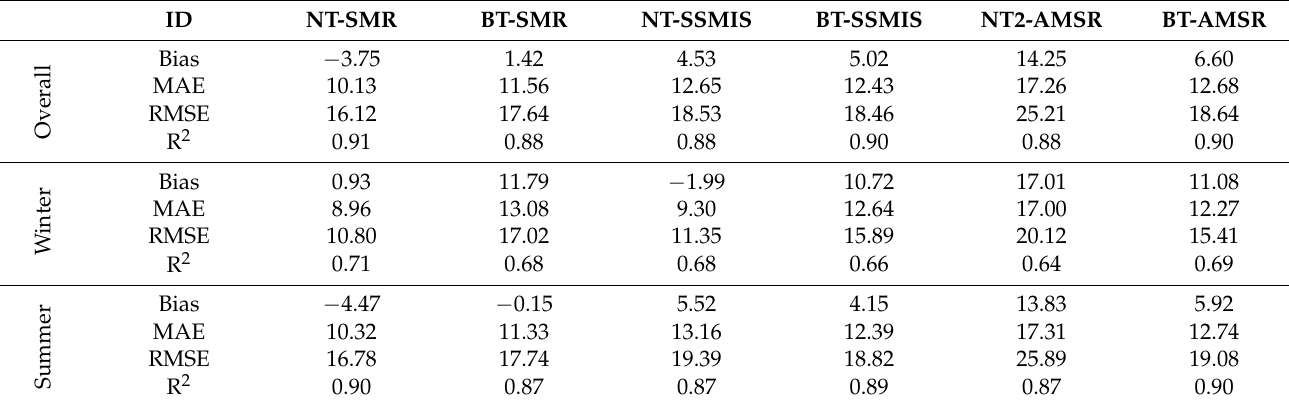
Figure 14. Same as in Figure 12 but in the Antarctic. Table 7. Same as in Table 6 but in the Antarctic.